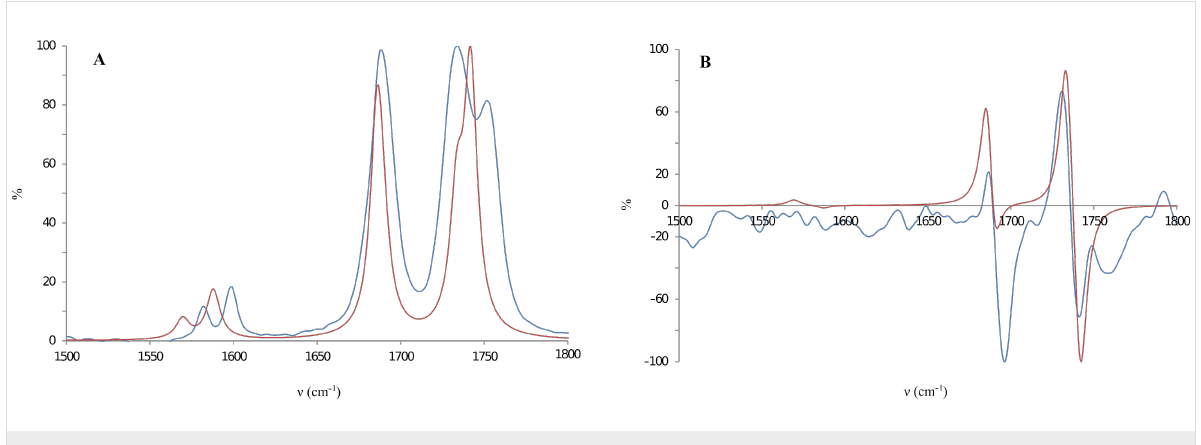
Figure 4: Calculated (red) and experimental (blue) IR (A) and VCD spectrum (B) of compound ( R )- 3a .